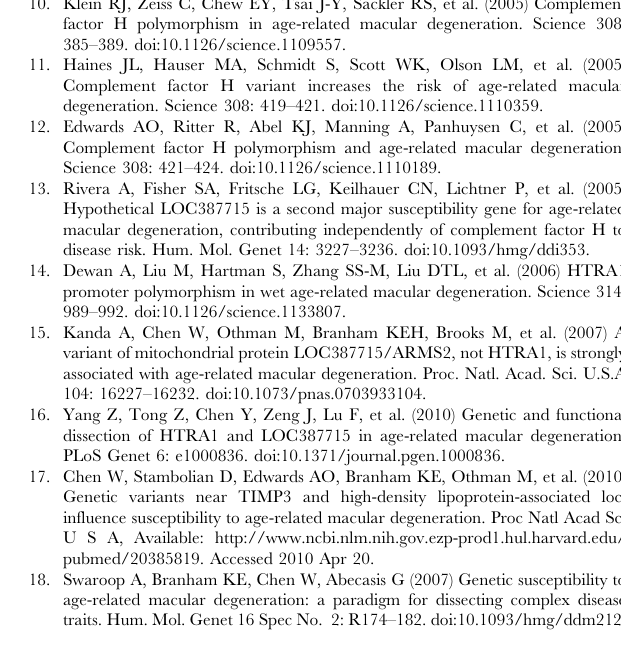
Figure S1 Linkage disequilibrium (r 2 ) between SNPs from the ROBO1 gene for wet or dry AMD in NESC (A) and in GREEK (B)